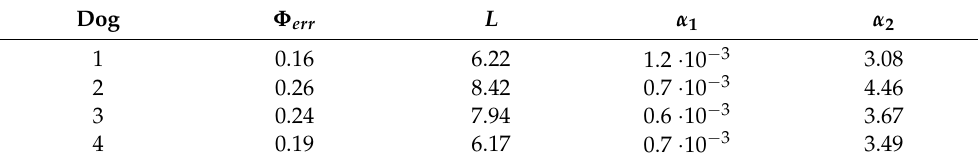
Table 1. Parameters providing optimal approximation to the experimental